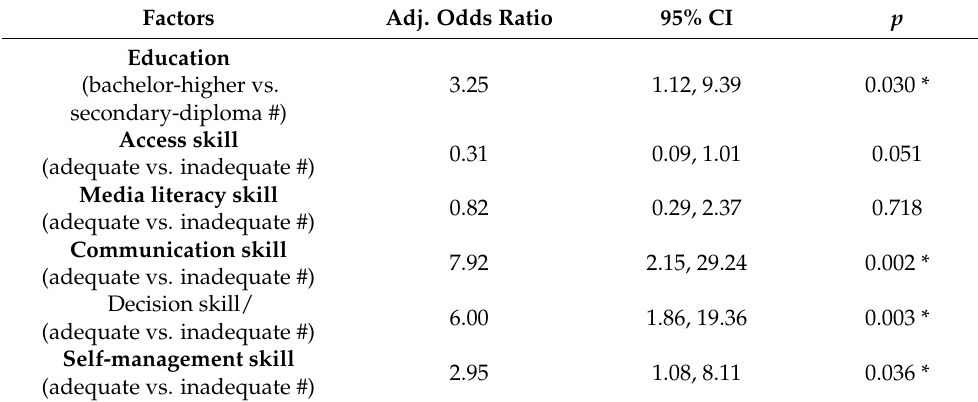
Table 5. The binary logistic regression model of associations between demographic and HL dimen- sions with TB prevention